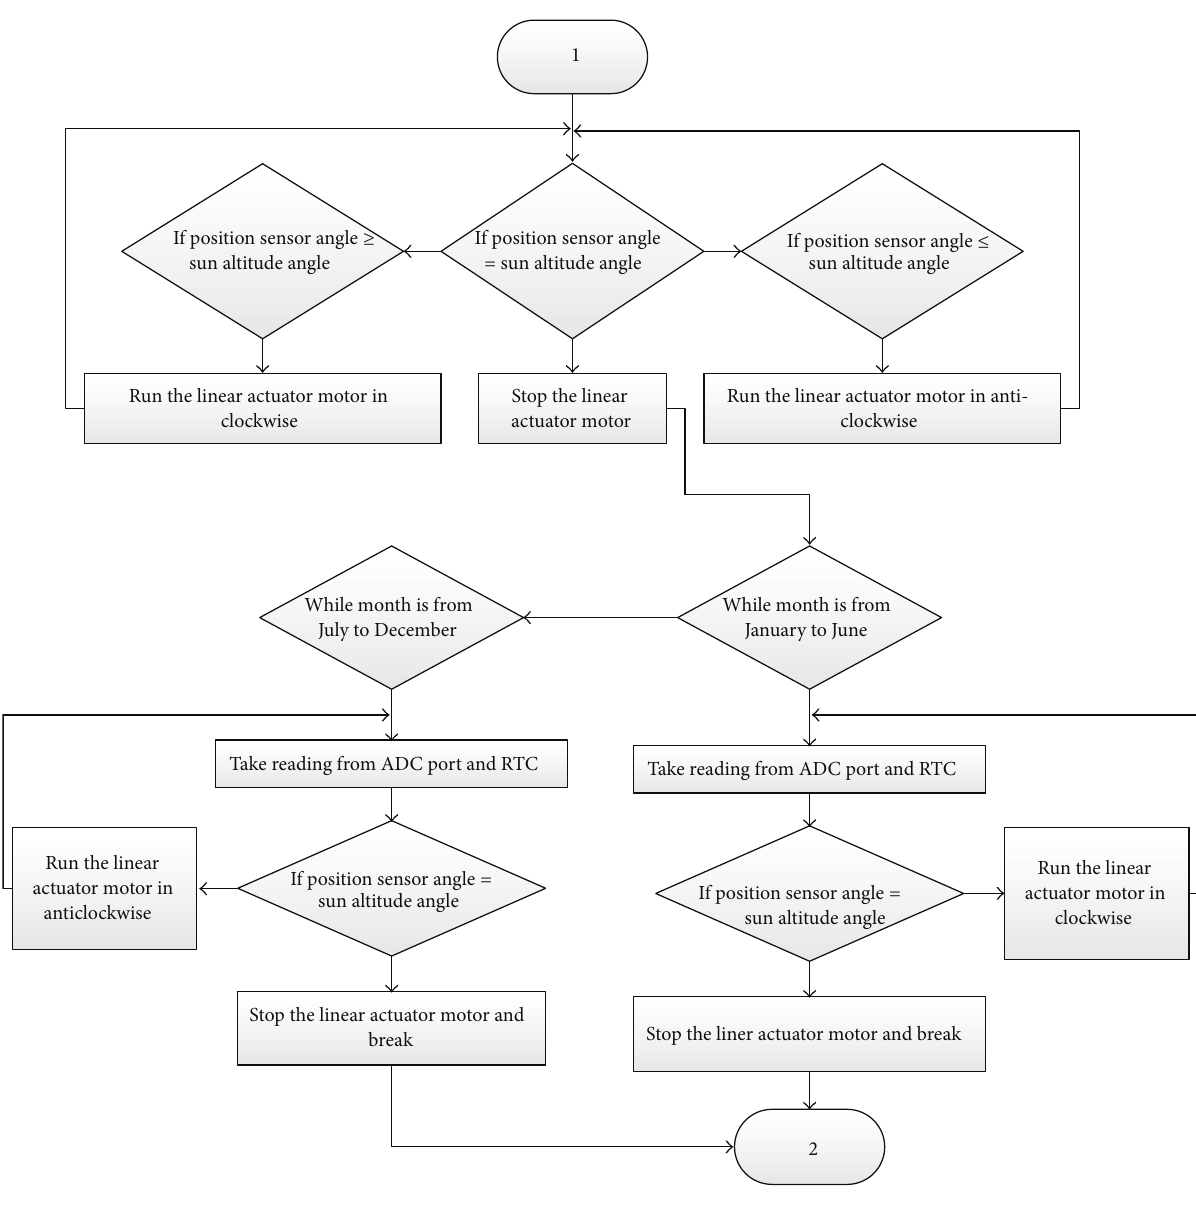
Figure 11: Continuation of main flowchart of microcontroller